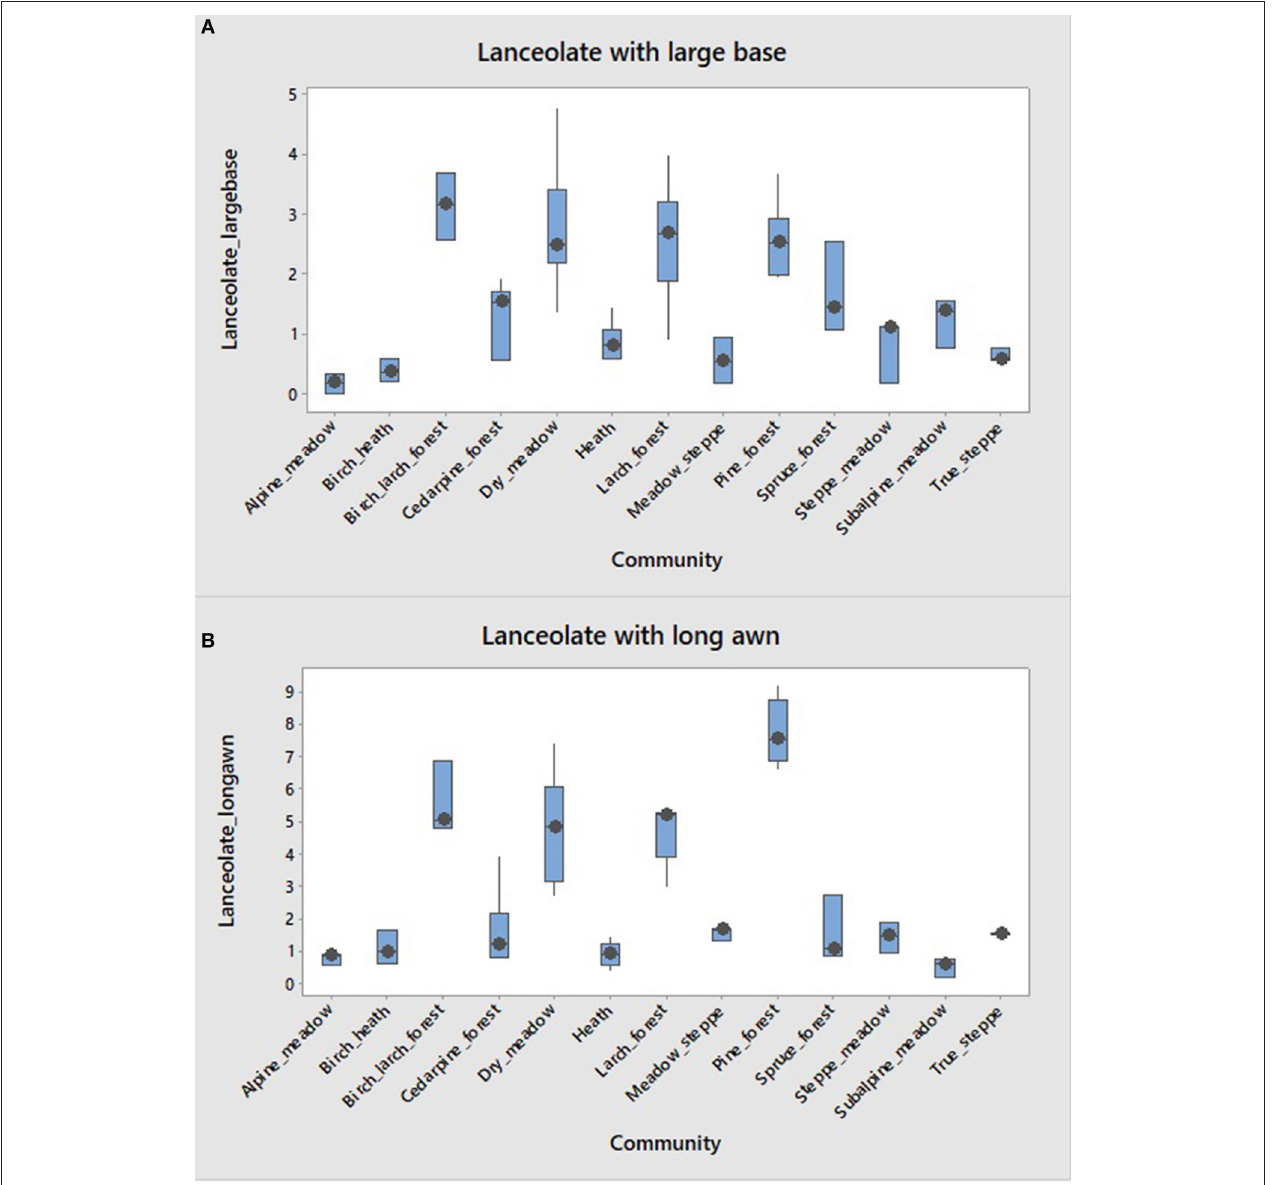
FIGURE 11 | Boxplots showing distribution of frequencies of two kinds of lanceolate forms. (A) large base short awn/”forest” and (B) small base long